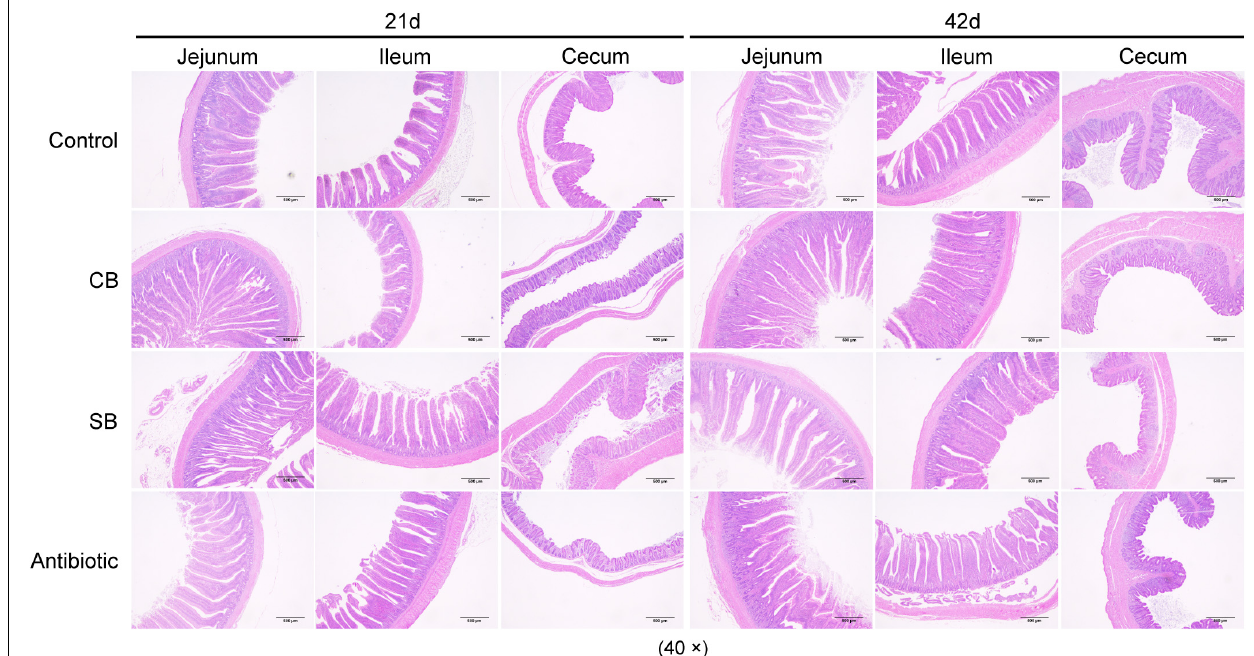
FIGURE 1 | Intestinal tissue morphology. Samples of jejunum, ileum, and cecum (approximately 1–2 cm obtained from the midpoint) at 21 and 42 d were fixed. Villi and goblet cells were observed from eosin-methylene blue-stained sections of samples by optical microscopy at 40 × .